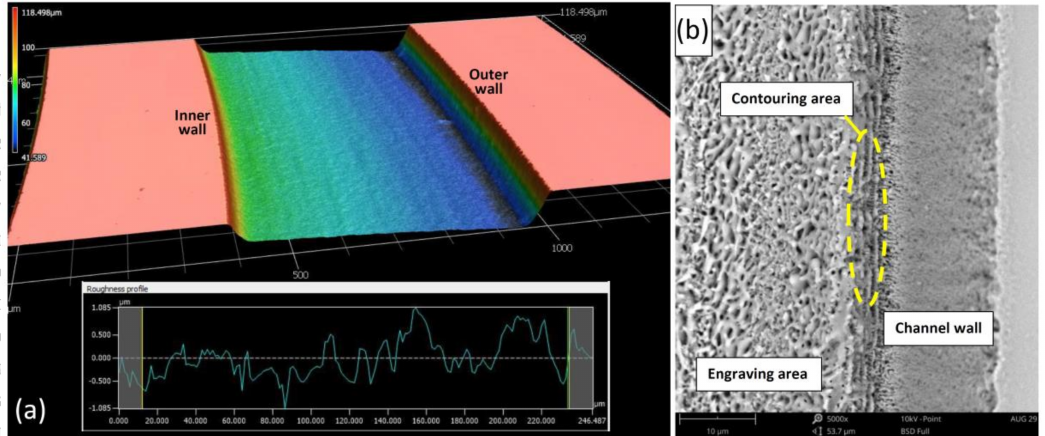
Figure 4. The fabricated spiral channel ( a ) 3D CLSM image of the fabricated channel with the roughness profile of the engraved area ( b ) 5000x SEM image of the fabricated channel showing the texture of the engraved, contouring, and wall areas of the